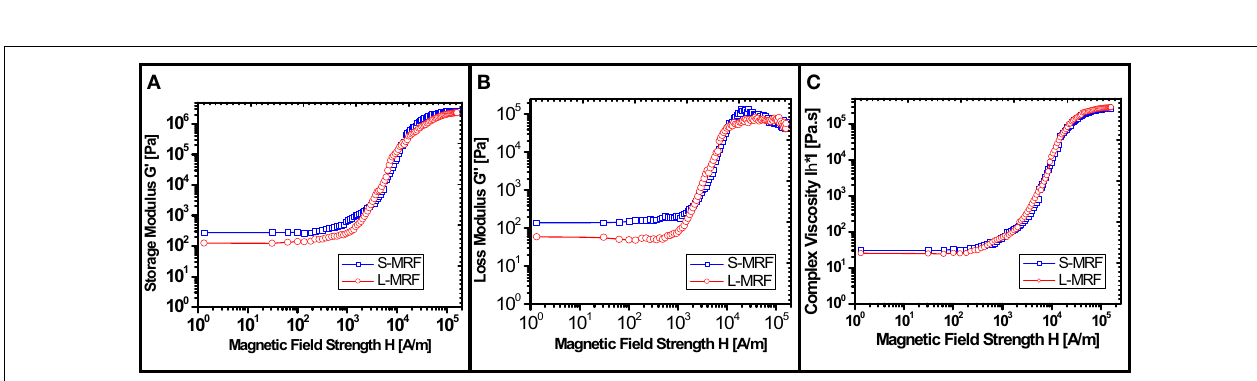
FIGURE 5 | Frequency sweep test for (A) S-MRF and (B) L-MRF samples under the application of magnetic field (filled symbol G (cid:48) , open symbol G (cid:48)(cid:48) ) is shown .